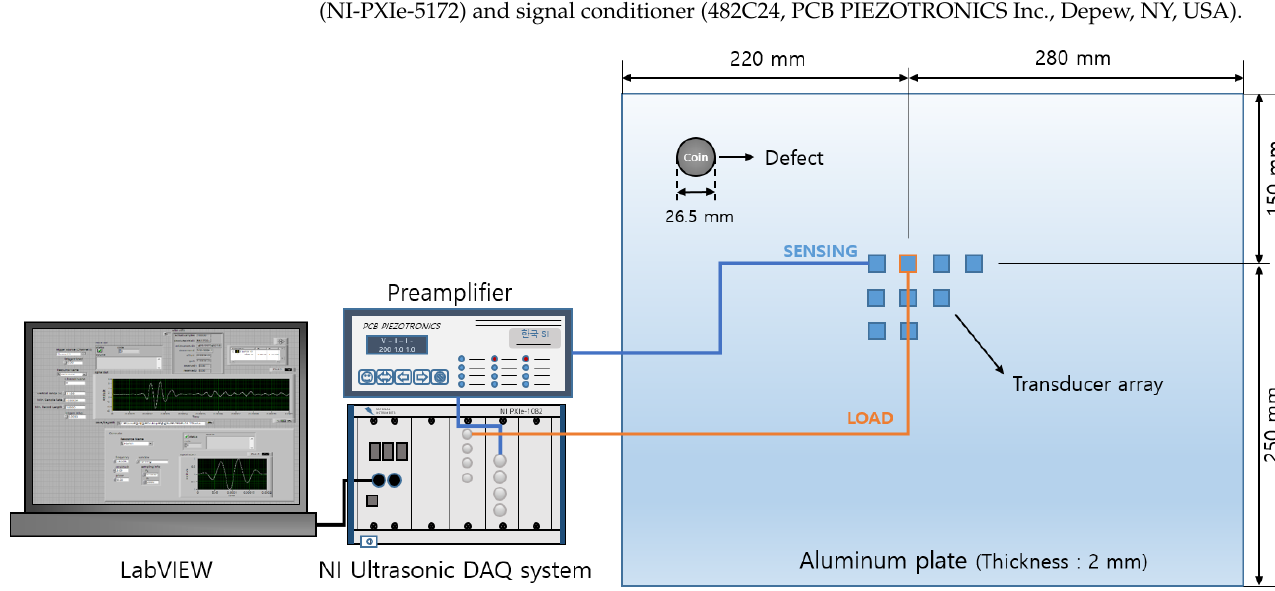
Figure 16. Schematic sketch of experimental setup.